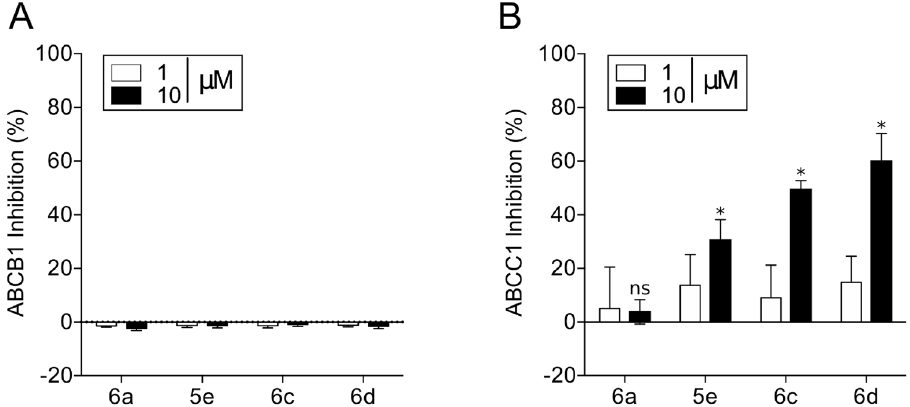
Figure 5. Selectivity of indeno[1,2- b ]indole derivatives toward ABCG2. ( A , B ) Effect of compounds at 1 and 10 µM on ABCB1 (P-gp) for rhodamine 123 transport inhibition and on ABCC1 (MRP1) for calcein-AM transport inhibition. The data are the mean ± SD of three independent experiments performed in duplicate and compared using the Student’s t test (2-sided) for independent samples. * p < 0.05 were considered significant for all